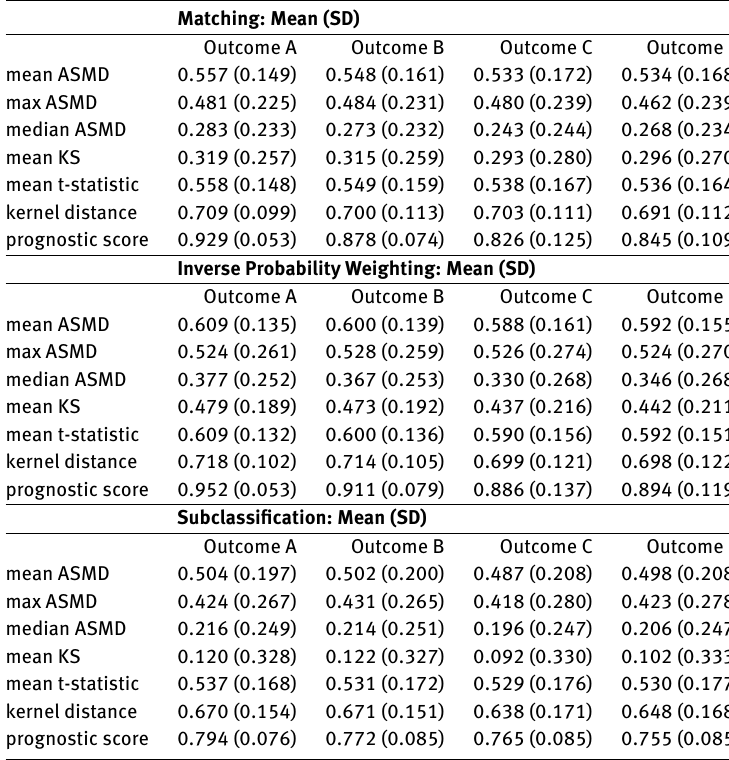
Table 3: Mean and standard deviation of the Spearman’s rank correlation